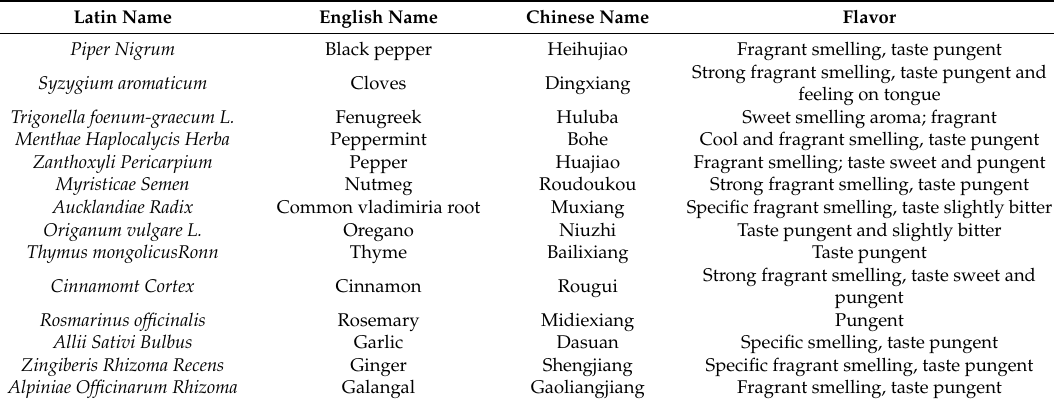
Figure 1. Process of discovering the pungent flavored materials from traditional Chinese medicines (TCMs). Table 1. The flavor of some pungent traditional Chinese medicines (TCMs).